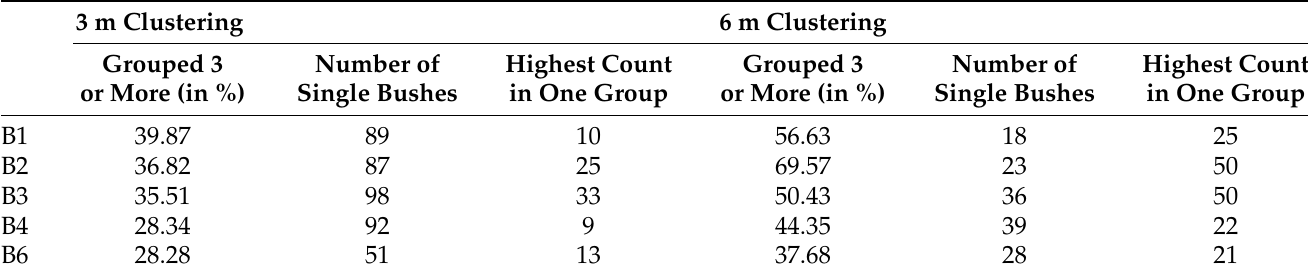
Table 2. Clustering results that are based on point shapefiles of the